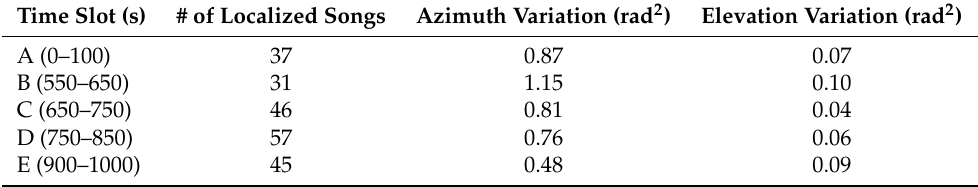
Figure 7. A song distribution on the polar coordinate of azimuth (angle) and elevation (radius) in each time slot (A–E) in Figure 5. Table 1. The variations in azimuth and elevation of localized sounds in each time